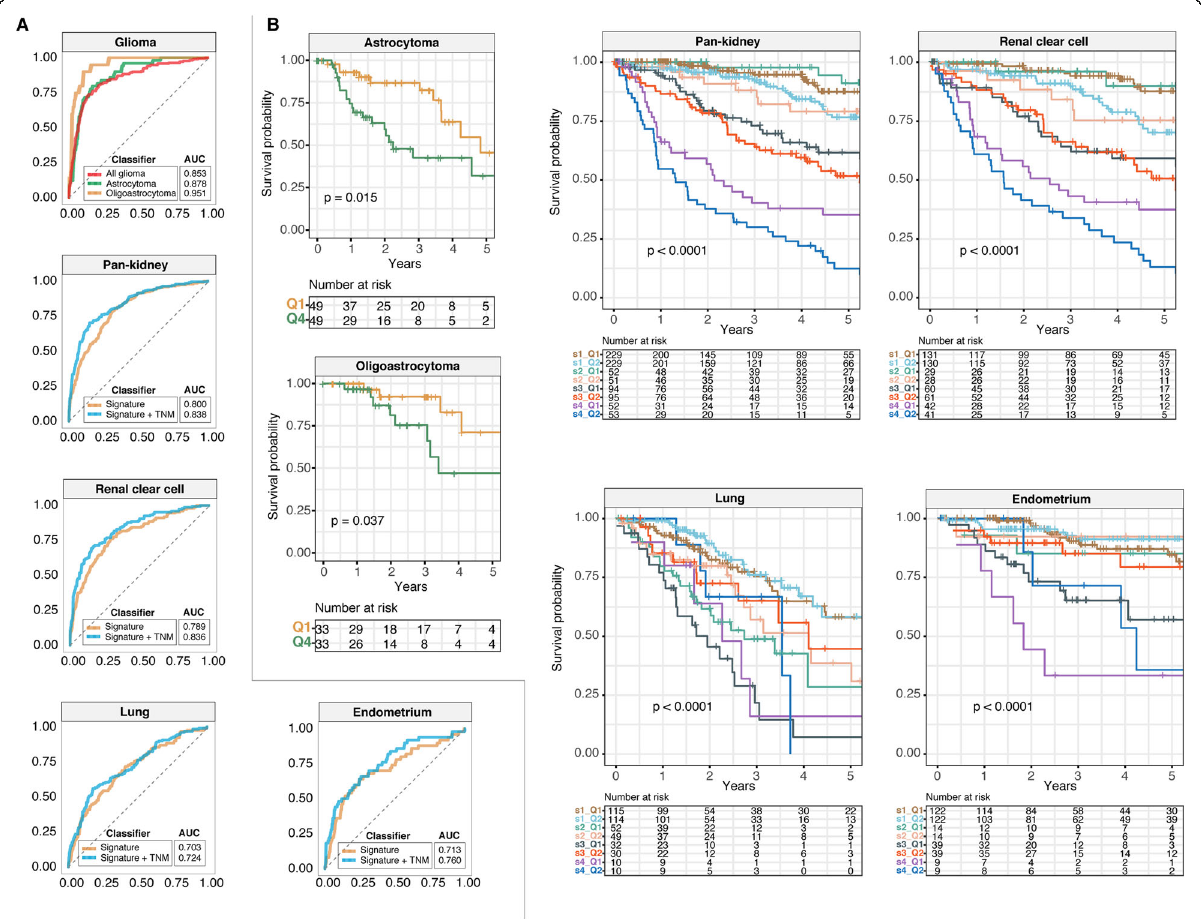
Fig. 3 The 28-gene signature is independent of tumor, node and metastasis (TNM) stage. a Receiver operating characteristic analysis is used to assess the predictive performance of the signature and TNM stage. For glioma patients, area under the curves (AUCs) are compared between histological subtypes. b Kaplan-Meier analyses of patients stratified by tumor stage or, in the case of glioma, by histological subtype and the 28- gene signature. For histological subtypes of glioma, log-rank tests are used to compare patients within the 1st and 4th survival quartiles. For the other cancers, patients are first stratified according to TNM stage followed by median-stratification into low- and high-score groups using the 28- gene signature. P values are obtained from log-rank